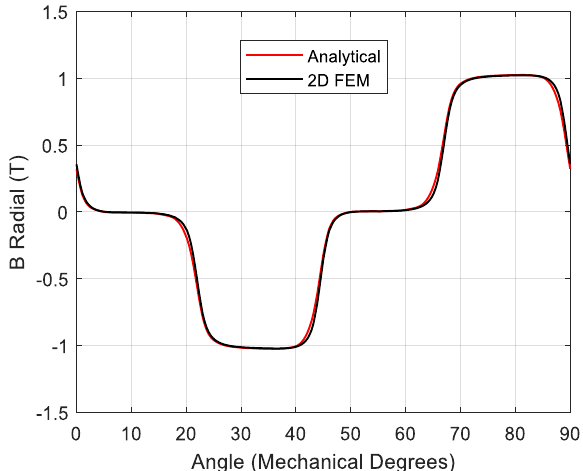
Figure 6. Radial component of the flux density distribution at the maximum torque point: 2D FEM (black) and analytical (red).